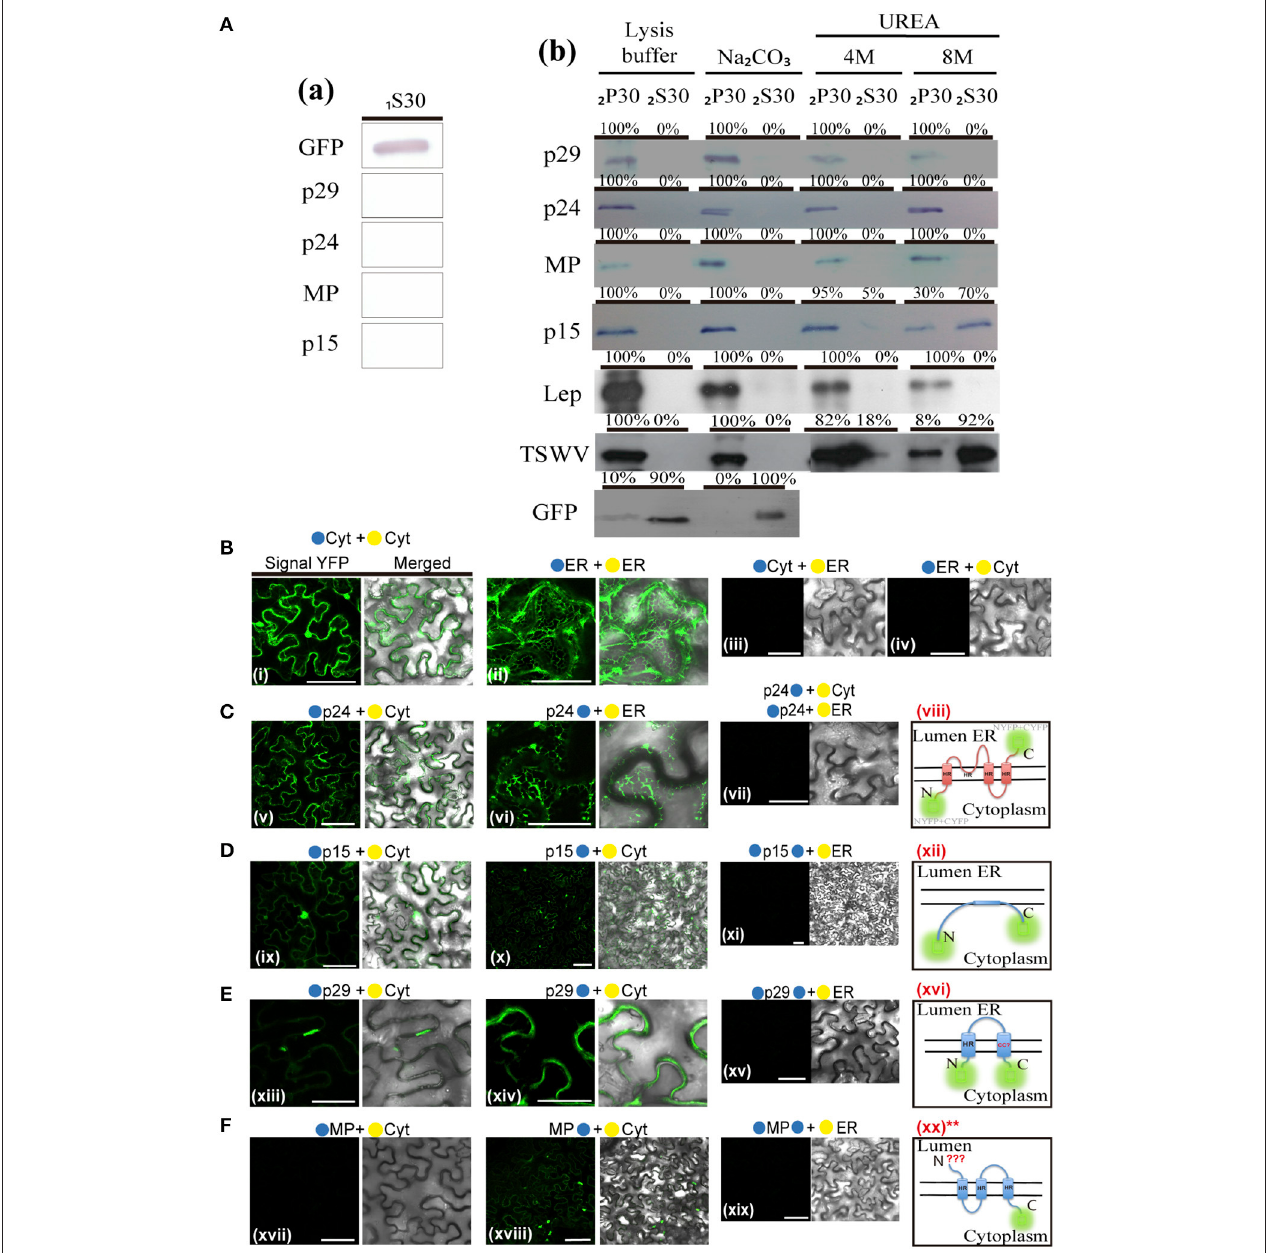
FIGURE 9 | Membrane association and topology of citrus leprosis virus C proteins. (A) Segregation into membranous and soluble fraction of p29, p15, MP, and p24 CiLV-C proteins expressed in planta . Respective proteins targeted with eGFP were expressed in N. benthamiana leaves by agroinfiltration. As control, we used leaf protein extracts containing unfused expressed eGFP, the HA-tagged LEP (leader peptidase) protein and HA-tagged NSm protein of TSWV, which have been showed to be non-membrane, integral membrane, and peripheral membrane proteins, respectively. The supernatant from first ultracentrifugation before membrane fraction ( 1 S30) (a) , and comparable pellet ( 2 P30) and supernatant ( 2 S30) obtained after membrane fractioning, untreated and alkaline or urea (4 or 8M) treatments (b) , were analyzed by Western blot method using an anti-NtGFP antibody (Sigma TM ) or anti-HA antibody (Fermentas TM ). Relative quantification values are presented in percentage. (B-F) Subcellular localization (cytosolic face or ER lumen) of the N- or C-termini of the p24 (C) , p15 (D) , p29 (E) , and MP (F) proteins. All proteins carrying the N-terminal (•) or C-terminal (•) YFP fragments fused at their N-(•/•–ORFs) or C-termini (ORFs-•/•) were transiently co-expressed in N. benthamiana leaves with corresponding complementary YFP fragment addressed to the cytosol face (•-cyt or •-cyt) or the lumen of the ER (•-ER or •-ER). Images reveal the topology of the N-terminus (v, ix, xiii, and xvii) or C-terminus (vi, x, xiv, and xviii) of the respective CiLV-C proteins. Positive and negative controls are presented in pictures (B) . Hypothetical topologic models are presented at the panels to the right of the figure for each respective protein (viii, xii, xvi, and xx). HR = hydrophobic region, N = N-terminus, C = C-terminus, CC? = possible membrane span coiled coil structure. **Correspond to the hypothetical model for MP, where only the localization of the C-terminus of the protein was characterized. All images contain two pictures corresponding to the YFP signal or merged with bright field. The fluorescence was monitored 4 days post-infiltration using a confocal Leica microscope SP8 model. Bars correspond to 50 µ m.